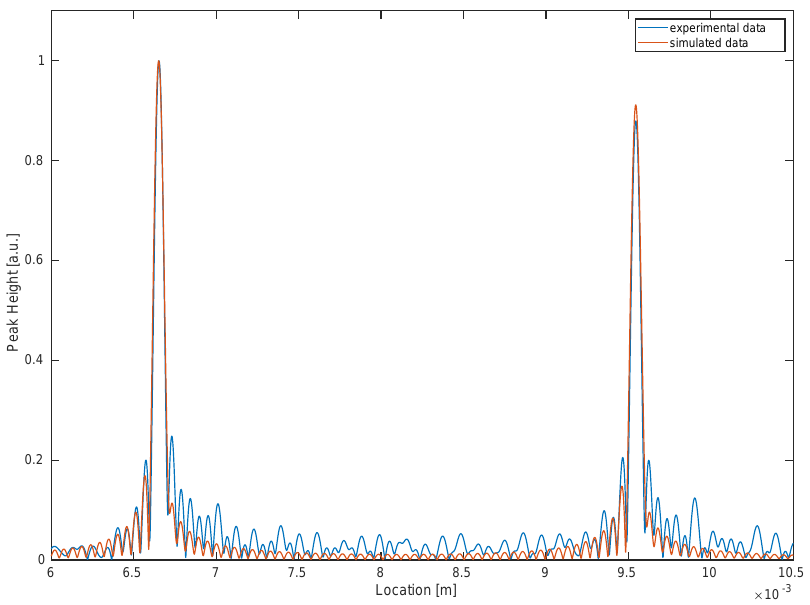
Figure 10. Comparison between experimental (blue) and simulated (red) data for a single